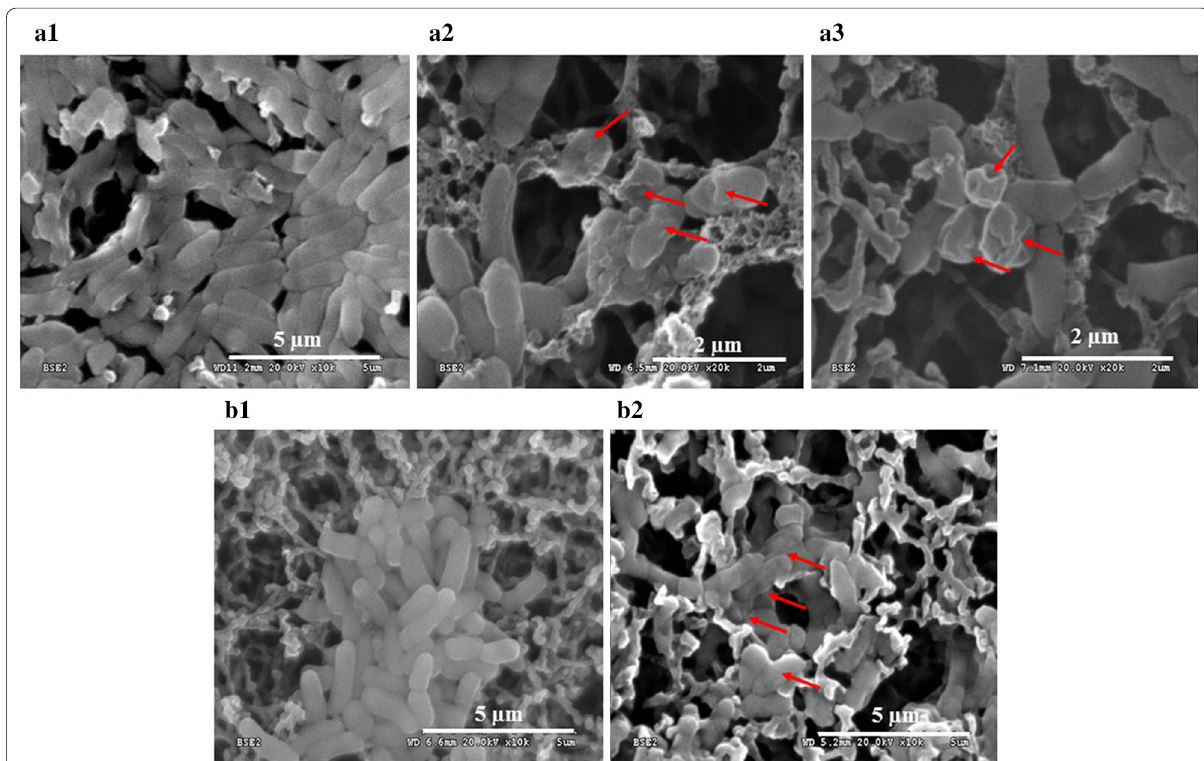
Fig. 5 Scanning electron microscopy shows the effects of B. amyloliquefaciens metabolites on B. pseudomallei and Escherichia coli . a1 B. pseudomallei control, a2 – a3 B. pseudomallei treated with precipitated proteins from culture supernatants of B. amyloliquefaciens . Arrows point to damage of bacteria cells. b1 E. coli control and b2 E. coli treated with precipitated proteins from culture supernatant of B.